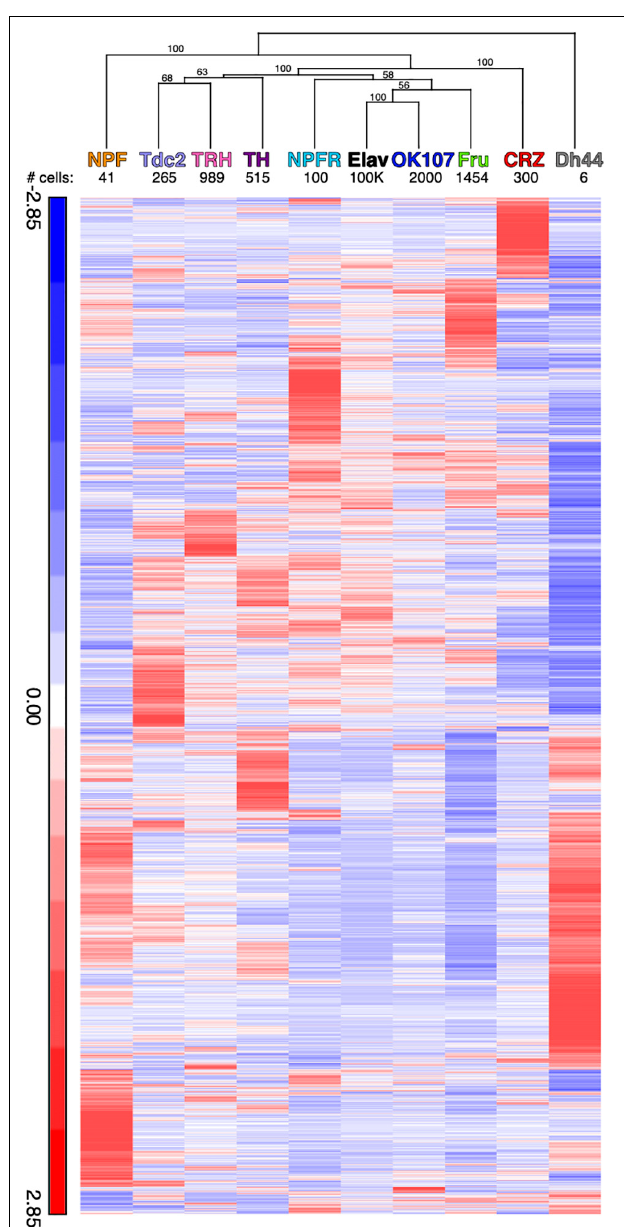
FIGURE 3 | Hierarchical clustering of average reads for all differentially expressed genes compared to the NPFR neurons. Clustering analysis was performed using Partek. Hierarchical clustering dendrogram with p -values. Values on the edges of the clustering are AU (Approximately Unbiased) p -values. Clusters with AU ≥ 95% are considered to be strongly supported by